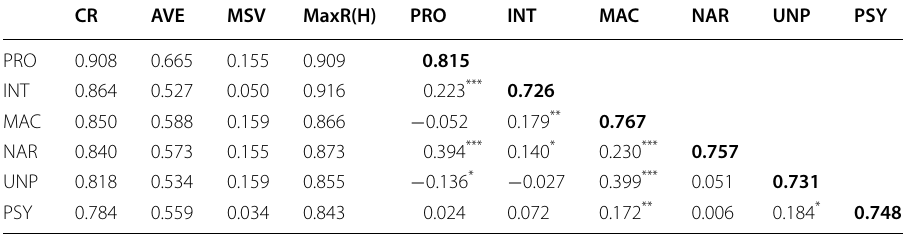
Bold values present the correlation value (Inter‑Construct Correlations) between variables of the correlation matrix Significance of correlations: * p < 0.050